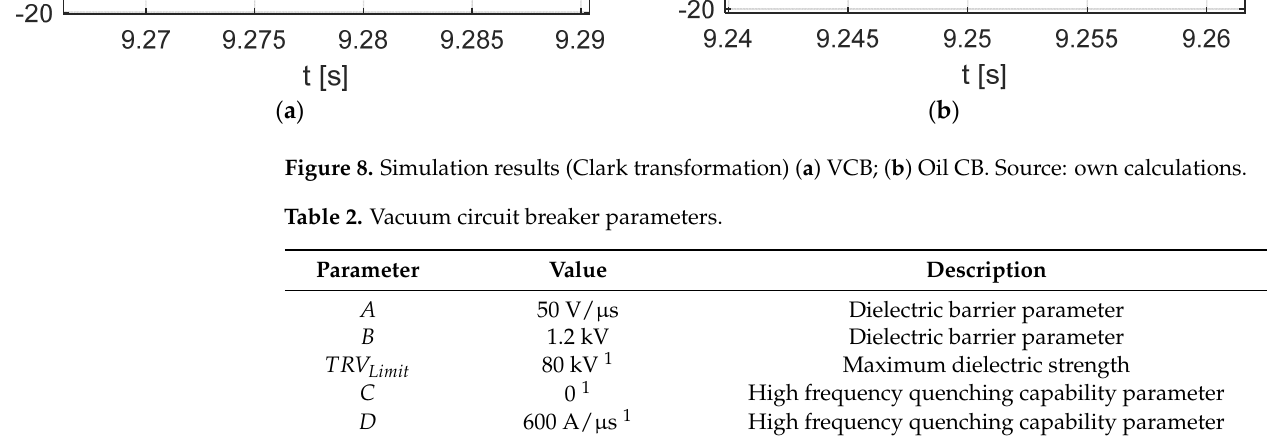
Figure 8. Simulation results (Clark transformation) ( a ) VCB; ( b ) Oil CB. Source: own calculations.